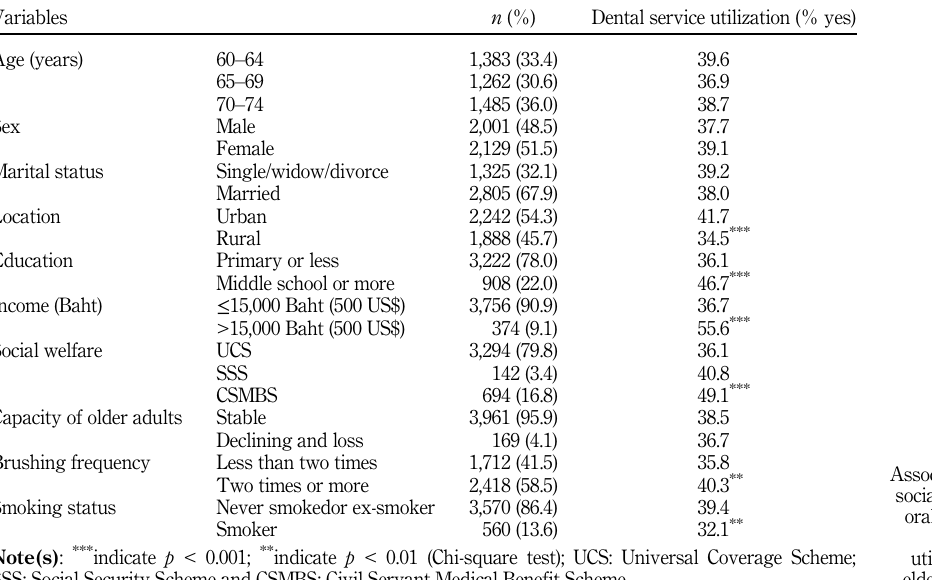
Table 1. Association